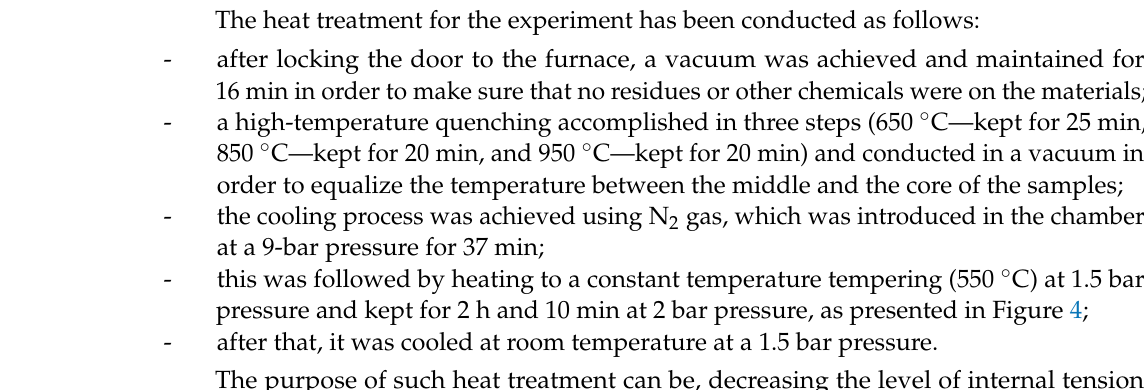
Figure 3. Heating diagram of the heat-treatment process (green—programmed and measured tem- perature, purple—vacuum, red—nitrogen